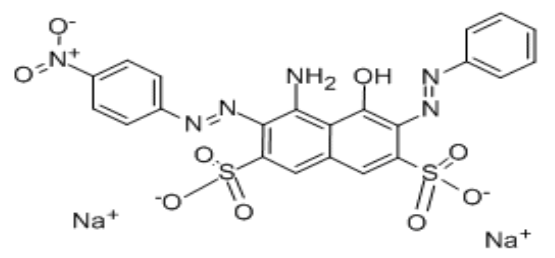
Figure 1. Chemical structure of acid black